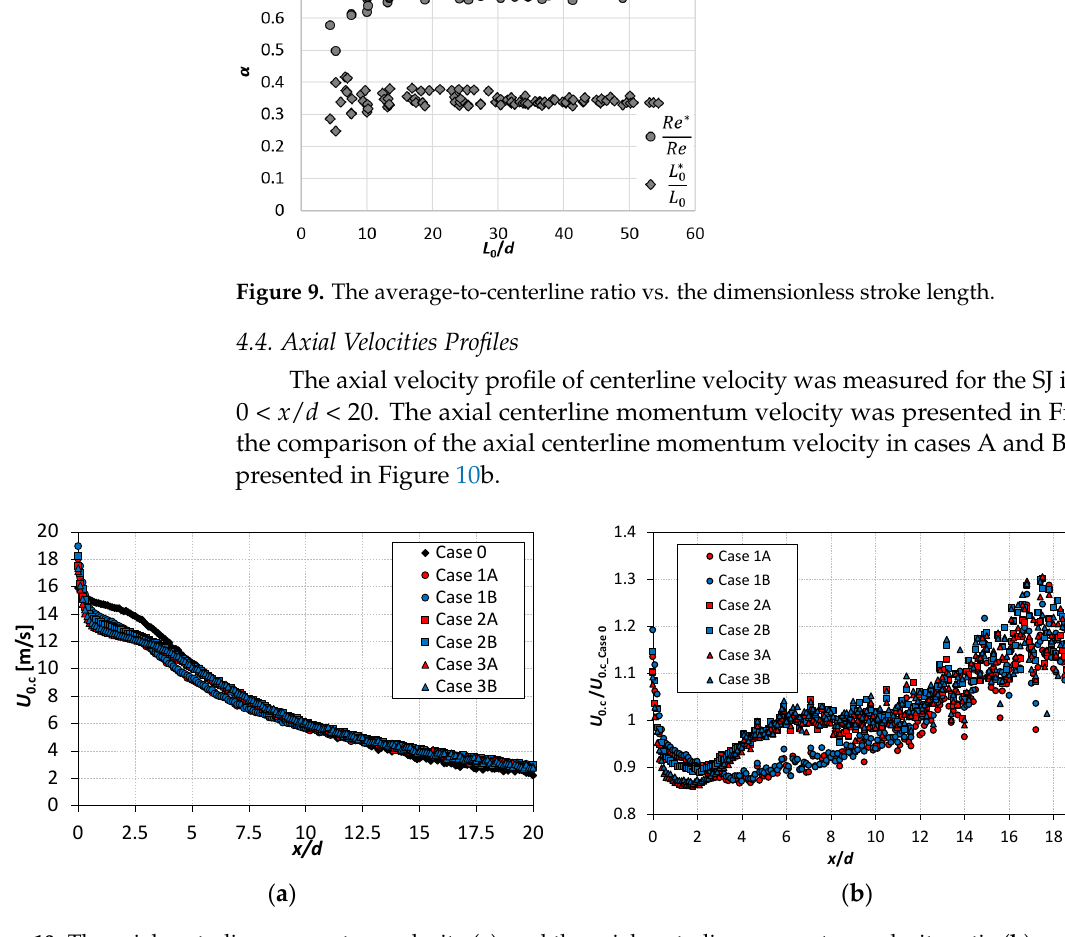
Figure 10. The axial centerline momentum velocity ( a ), and the axial centerline momentum velocity ratio ( b ) as a function of axial distance x/d , at the characteristic frequency and real power p = 5 W.